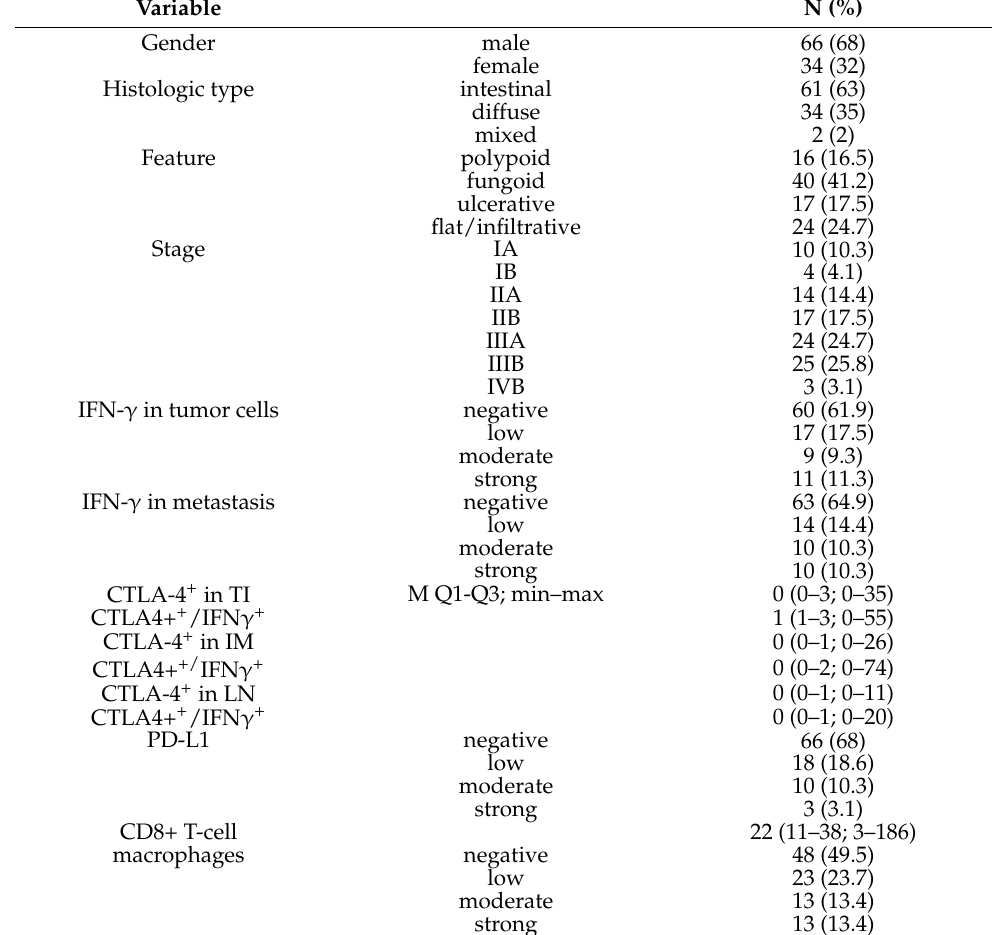
Table 1. Demographic and clinicopathological data of patients with